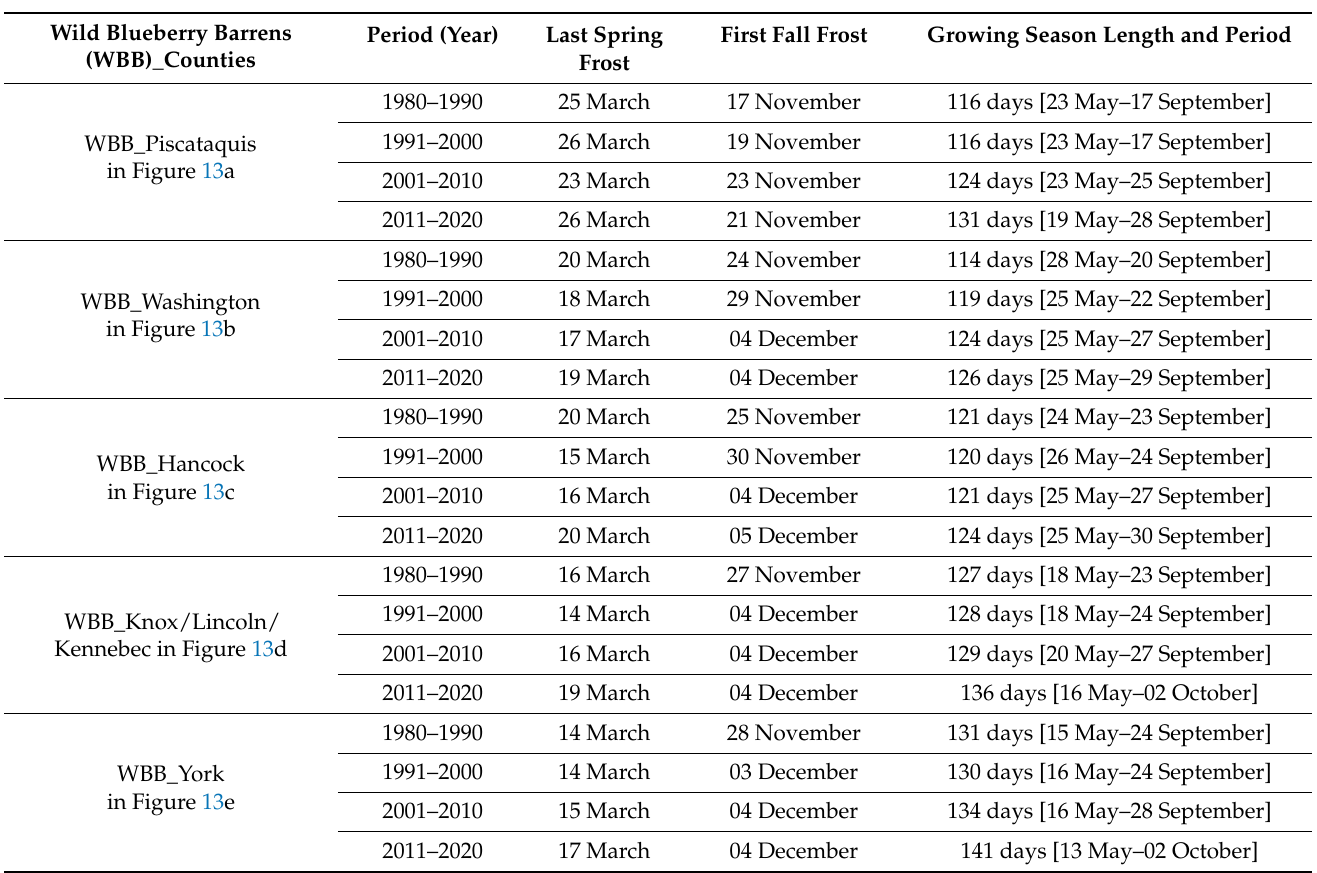
Table 3. Approximate last spring frost dates, first fall frost dates, and growing season period